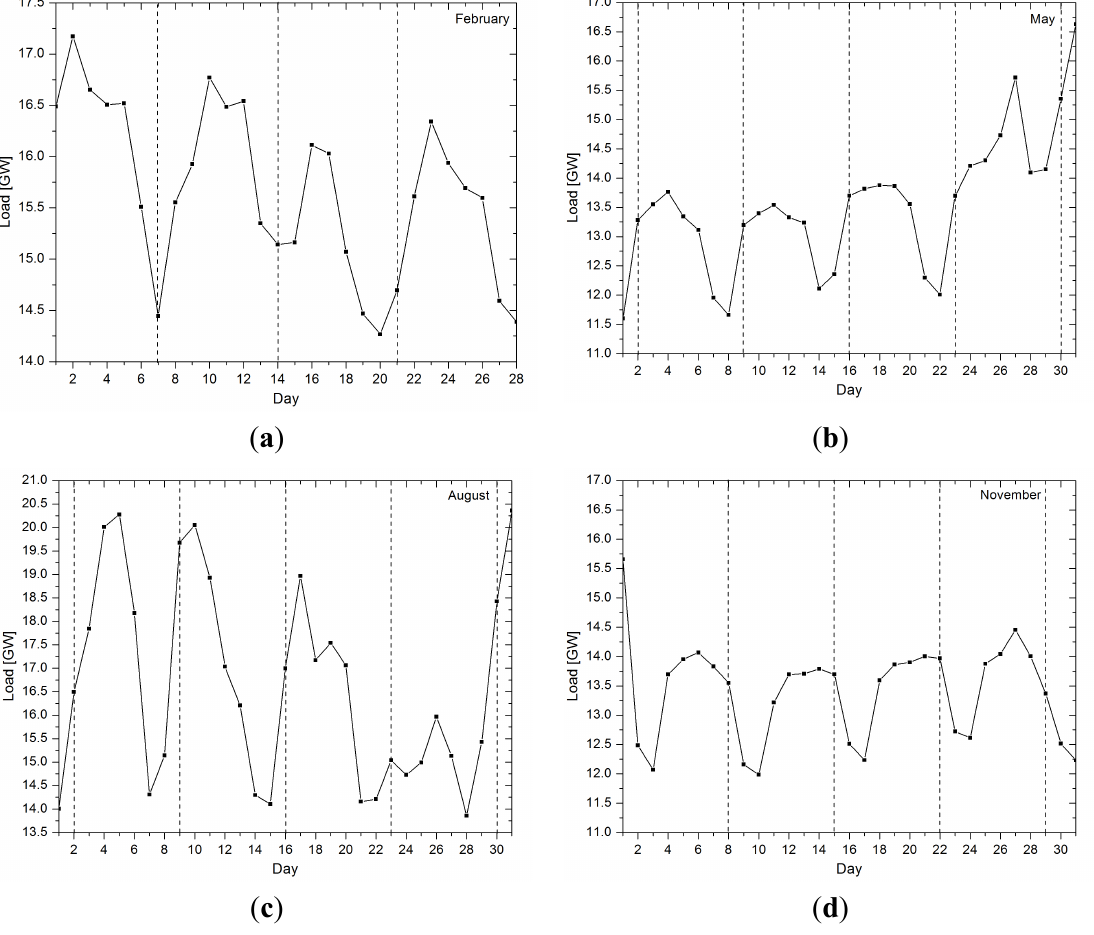
Figure 4. Average daily load in ( a ) February 2011; ( b ) May 2011; ( c ) August